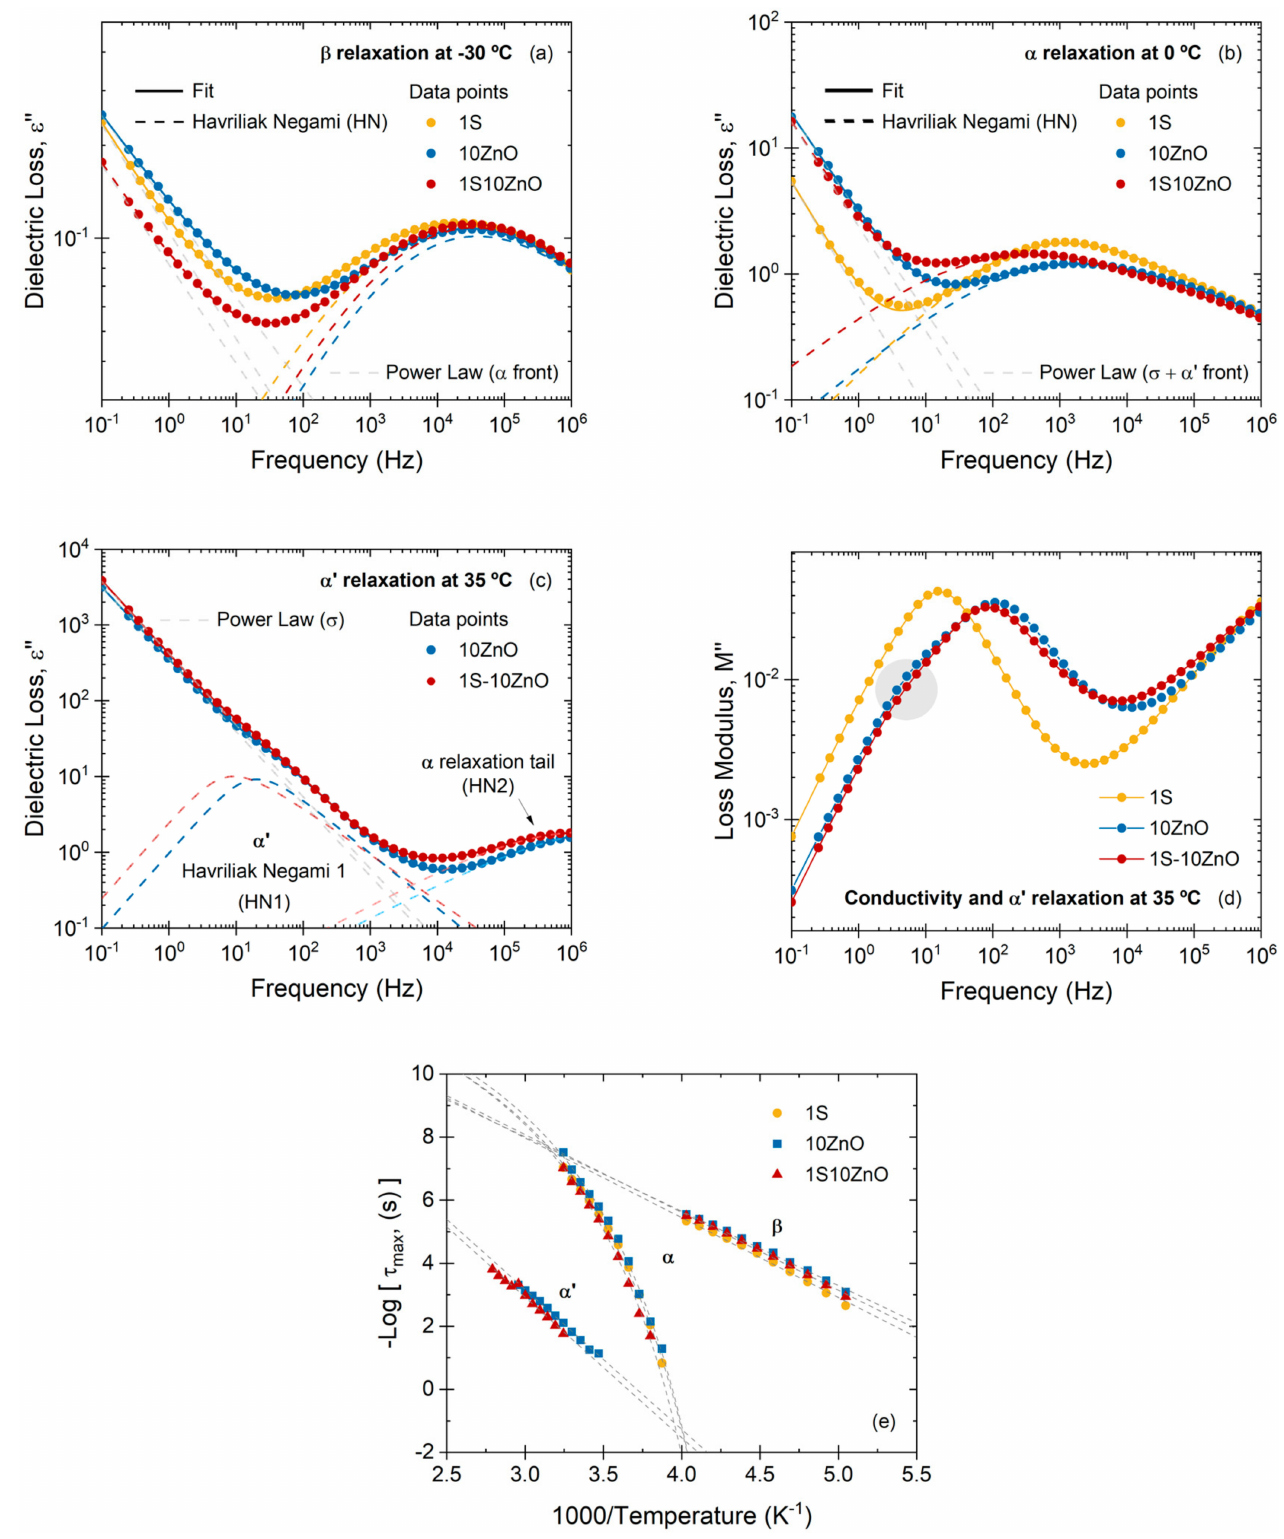
Figure 10. ( a ) β , ( b ) α , and ( c ) α (cid:48) relaxation of 1S, 10 ZnO, and 1S-10 ZnO at selected temperatures, ( d ) loss modulus M (cid:48)(cid:48) of compounds at selected temperature, and ( e ) activation diagram of the three relaxations in XNBR compounds. The dashed lines indicate the fittings of ( a – c ) Havriliak–Negami and power law function, and ( e ) the Arrhenius and VFT function, to the experimental